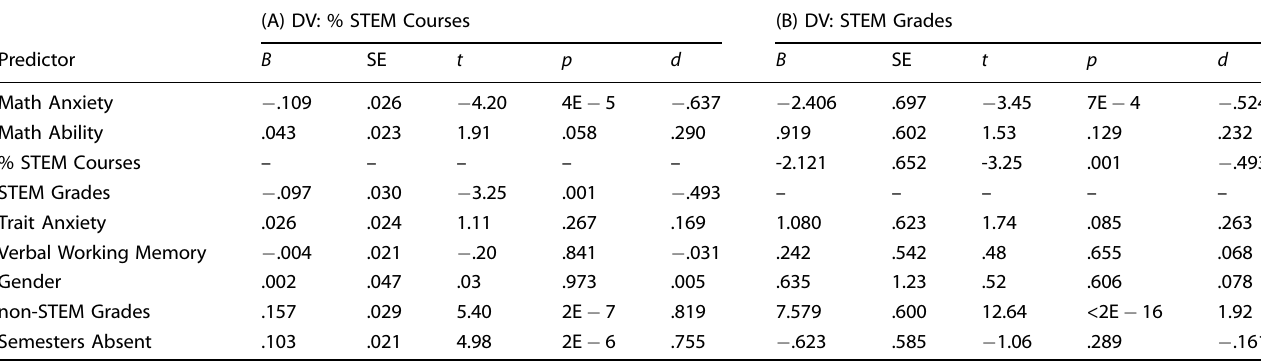
Table 1. Multiple regression models assessing the unique predictive effects of fi rst-semester Math Anxiety and Math Ability on university STEM outcomes.